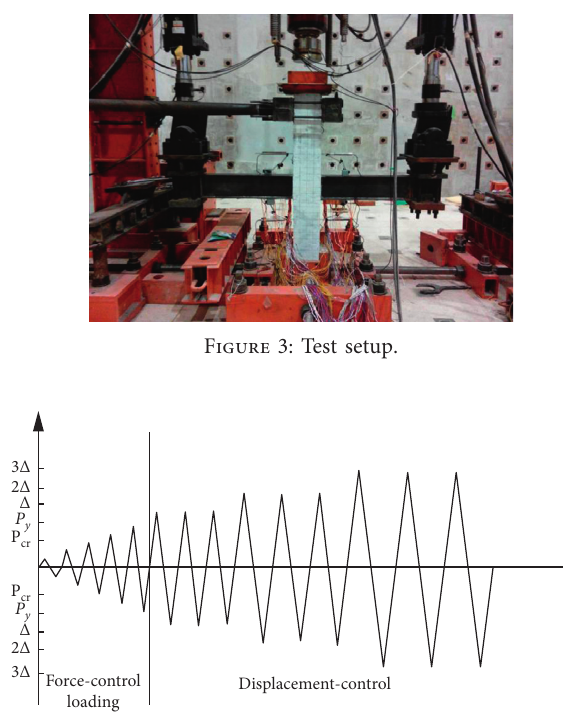
Figure 4: Loading scheme for cyclic